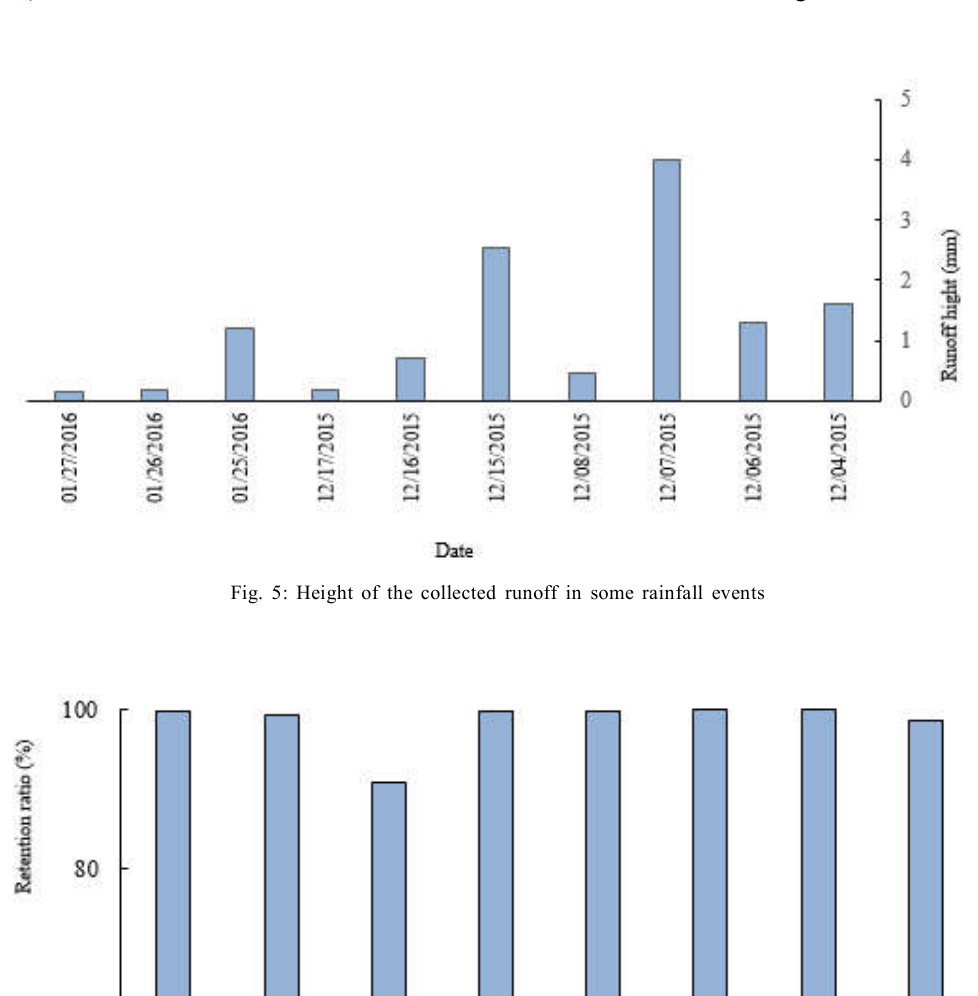
Fig. 5: Height of the collected runoff in some rainfall events